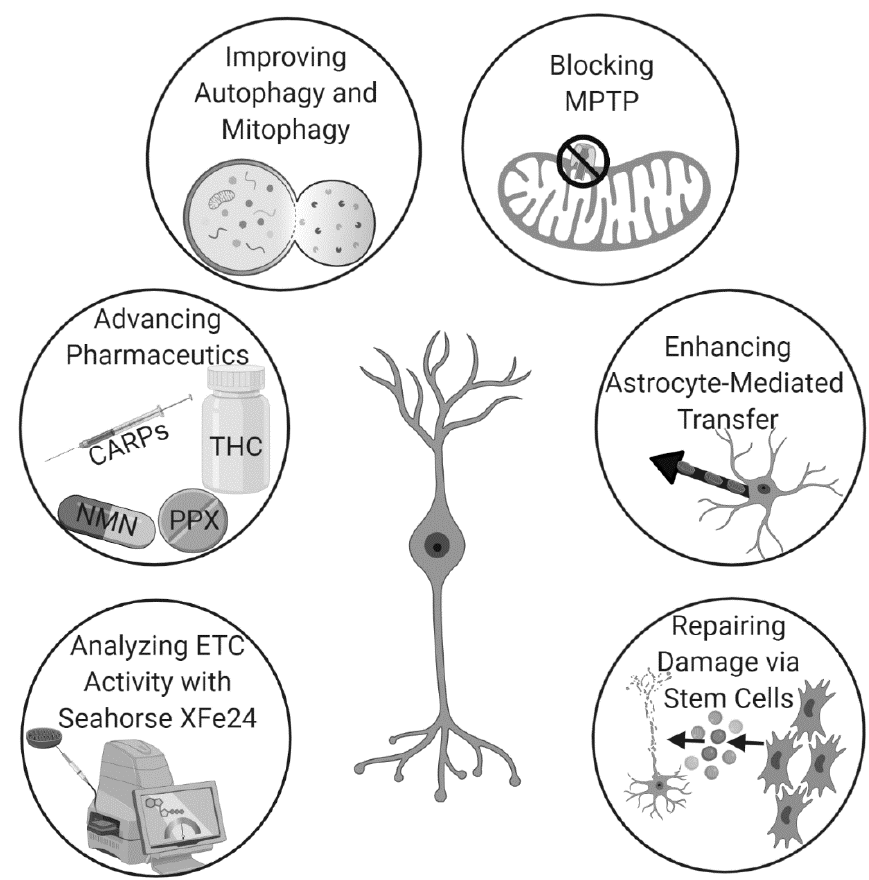
Figure 2. The use of mitochondrial repair for stroke is rapidly gaining momentum due to recent advancements in analytics, pharmaceutics, techniques that augment endogenous mechanisms, and stem cell therapy.